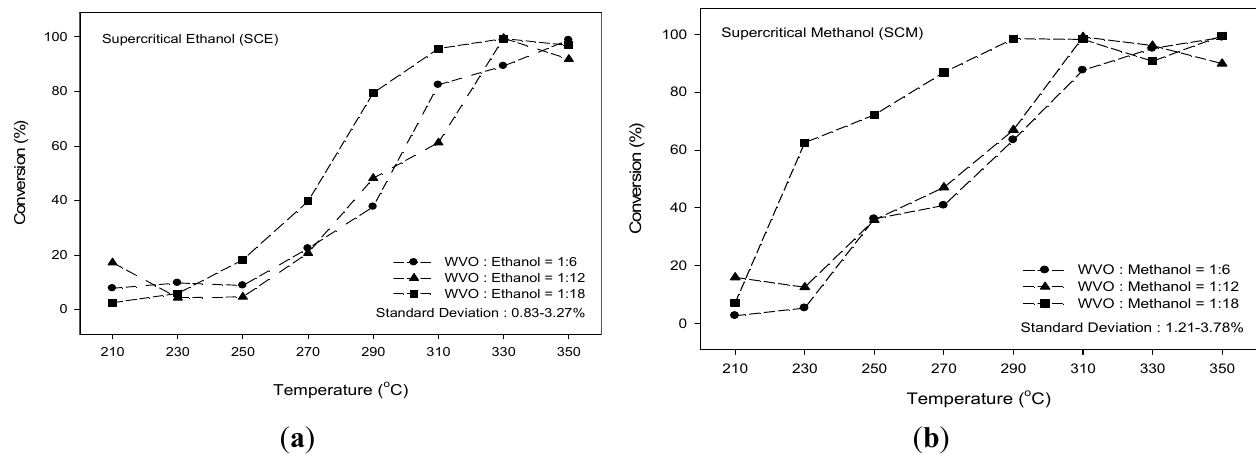
Figure 3. Comparison of conversion in SCE and SCM with WVO and alcohols at